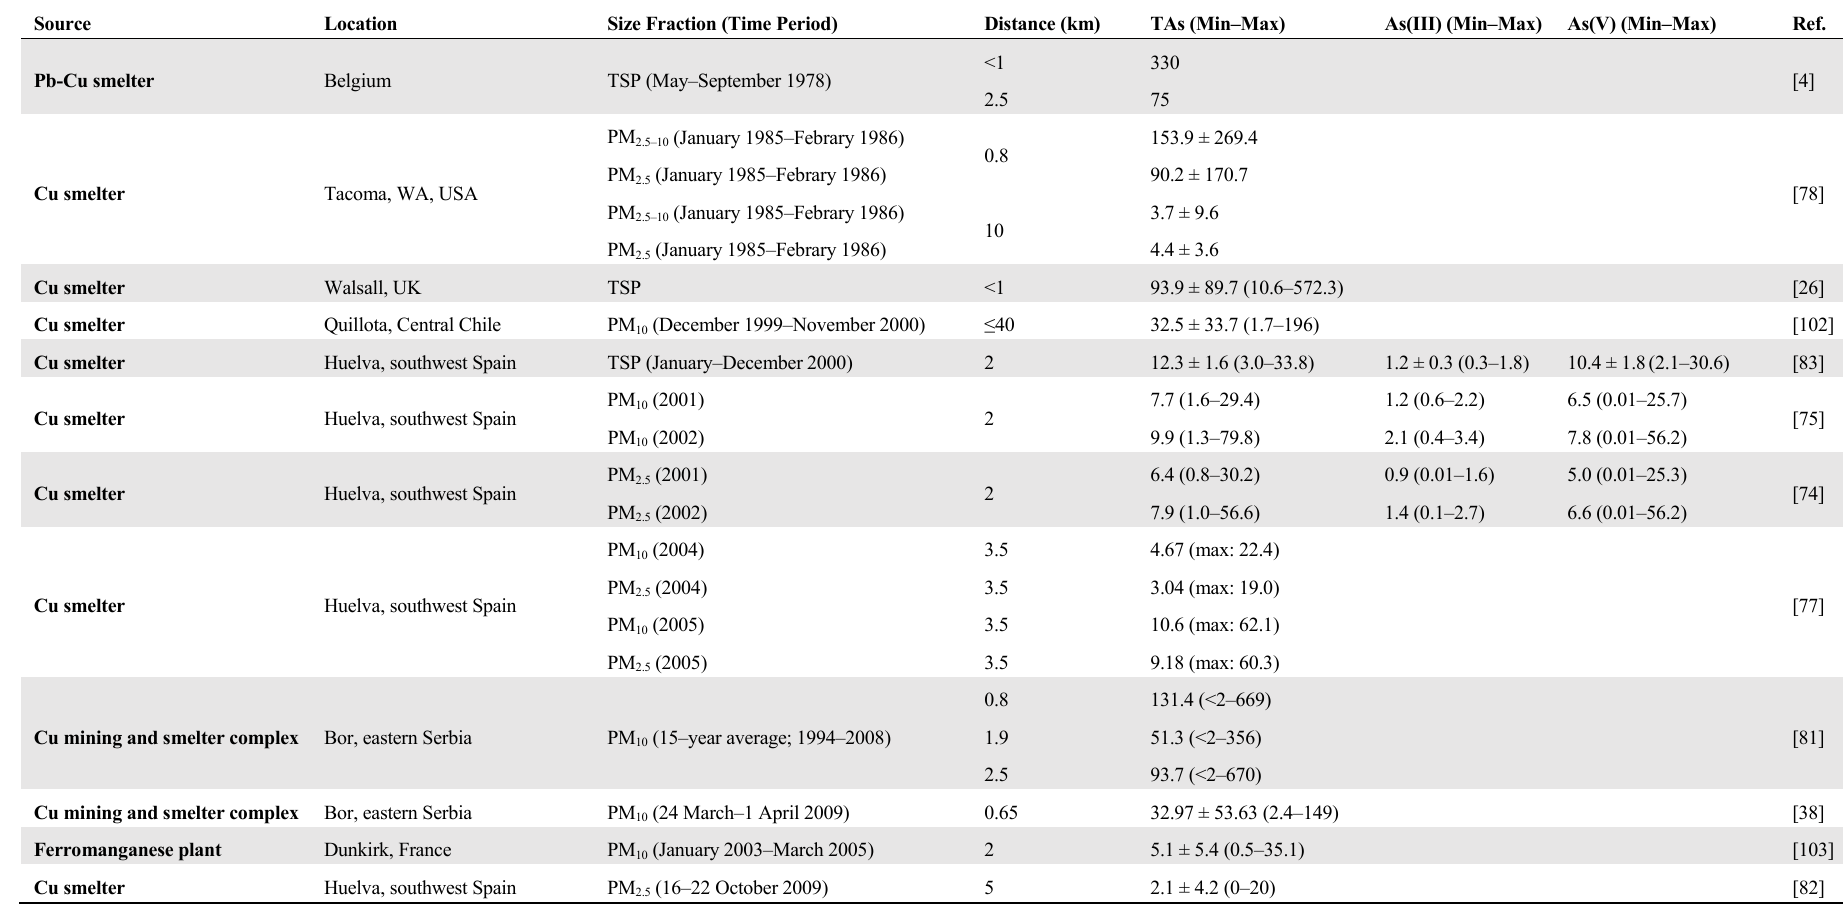
Table 1. Summary of the average, minimum and maximum total arsenic (TAs) concentrations recorded in particulate matter (PM) from various mining operations, including smelting, coal combustion and mine waste. Values for TAs are expressed as nanogram per cubic meter (ng·m − 3 ) unless otherwise specified. Where applicable, all units of distance measurement have been converted to metric